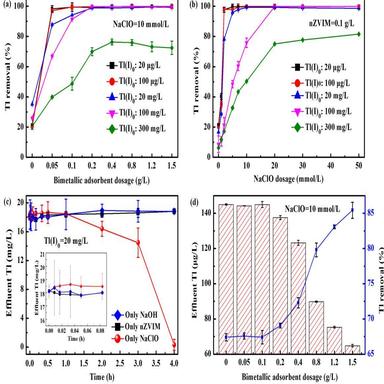
The effect of (a) nZVIM dosage and (b) NaClO dosage on Tl(I) removal; (c) the Tl(I) removal by NaOH, nZVIM and NaClO alone; (d) the Tl(I) removal from actual industrial wastewater (solution pH = 10, reaction temperature = 298 K, reaction time = 30 min).